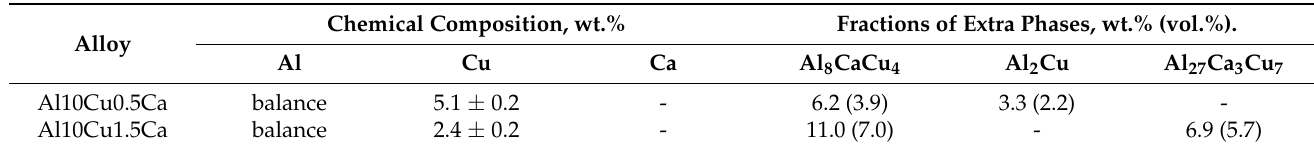
Figure 9. SEM microstructure of the alloys: ( a ) Al10Cu0.5Ca and ( b ) Al10Cu1.5Ca after homogeni- zation annealing at 530 °C for 12 h. Table 4. The measured chemical composition of the aluminum matrix (Al) after homogenization and calculated fractions of extra phases.